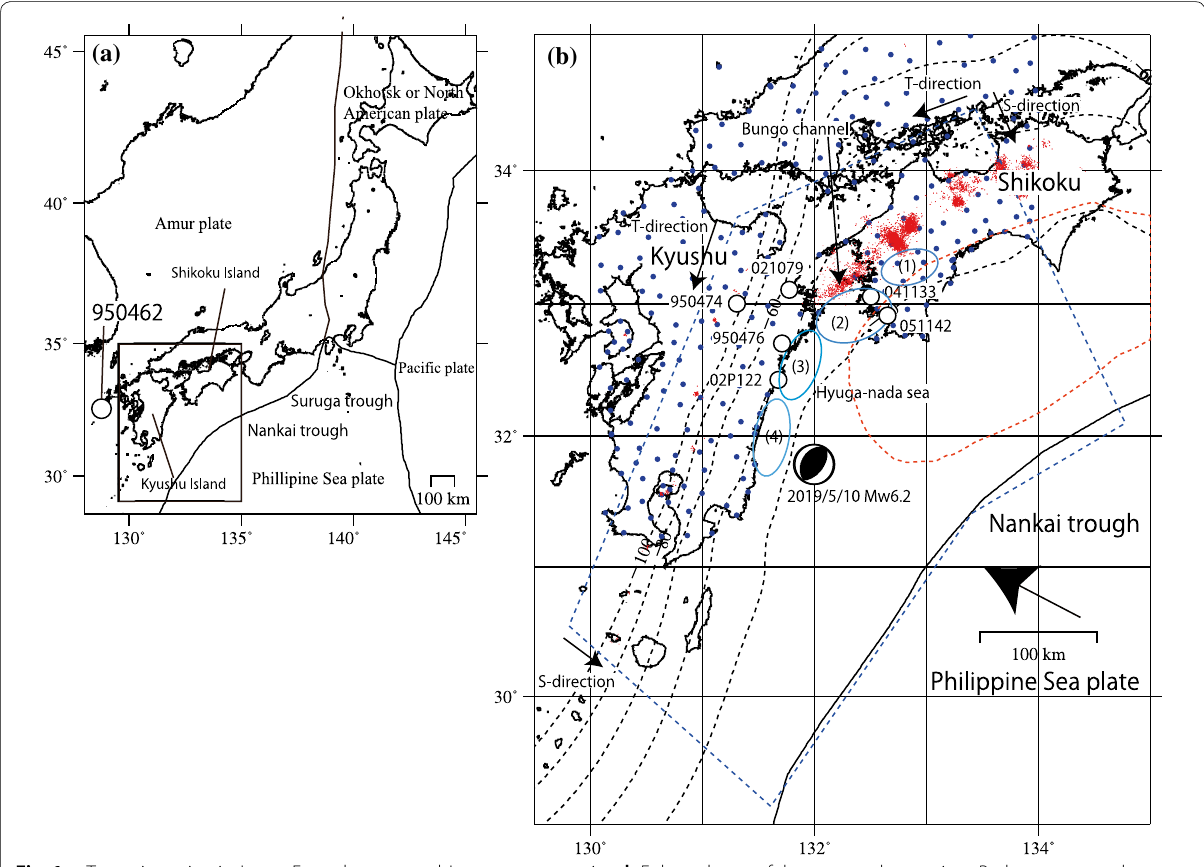
Fig. 1 a Tectonic setting in Japan. Four plates around Japan are converging. b Enlarged map of the rectangular area in a . Broken contours show iso-depth contours of the plate interface between the subducting Philippine Sea plate and overriding Amur plate. The contour interval is 20 km. Red dots indicate the epicenters of low-frequency earthquakes. Blue ellipses schematically indicate long-term slow slip events along the Shikoku and Kyushu coasts. (1) Western Shikoku SSE. (2) Bungo SSE. (3) Northern Hyuga-nada Sea SSE. (4) Southern Hyuga-nada Sea SSE. The focal solution shows the mechanism of the 2019 Hyuga-nada Sea earthquake with Mw 6.2. The blue broken line indicates the area of the plate interface adopted in the time-dependent inversion. Blue circles show the locations of the GNSS sites used in the time-dependent inversion. The red broken line shows the expected source region of the next Nankai earthquake (Central Disaster Council of the Japanese Government